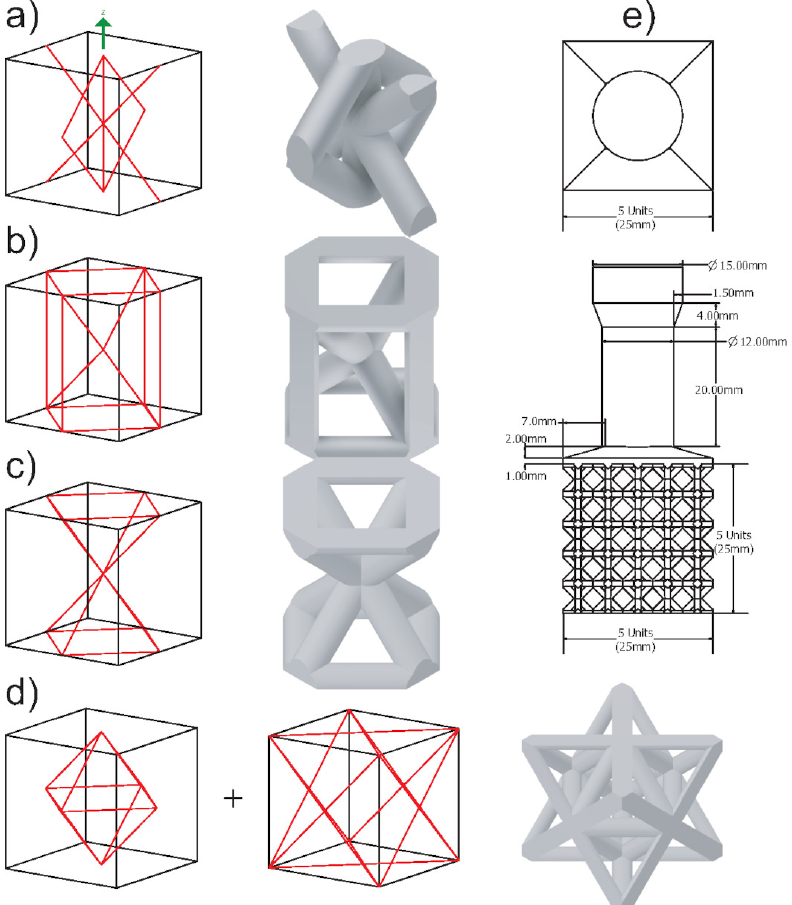
Figure 4. Test 2 lattice cells and structure: ( a ) Proposed cell. ( b ) Hourglass. ( c ) Rhombic. ( d ) Octet- Truss. ( e ) 5 × 5 × 5